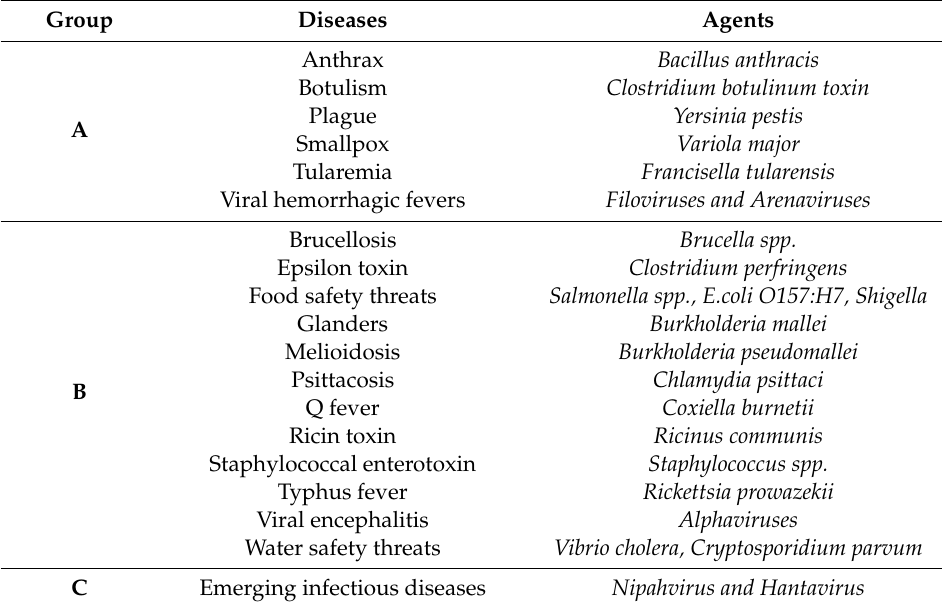
Table 1. Main biological threat agents